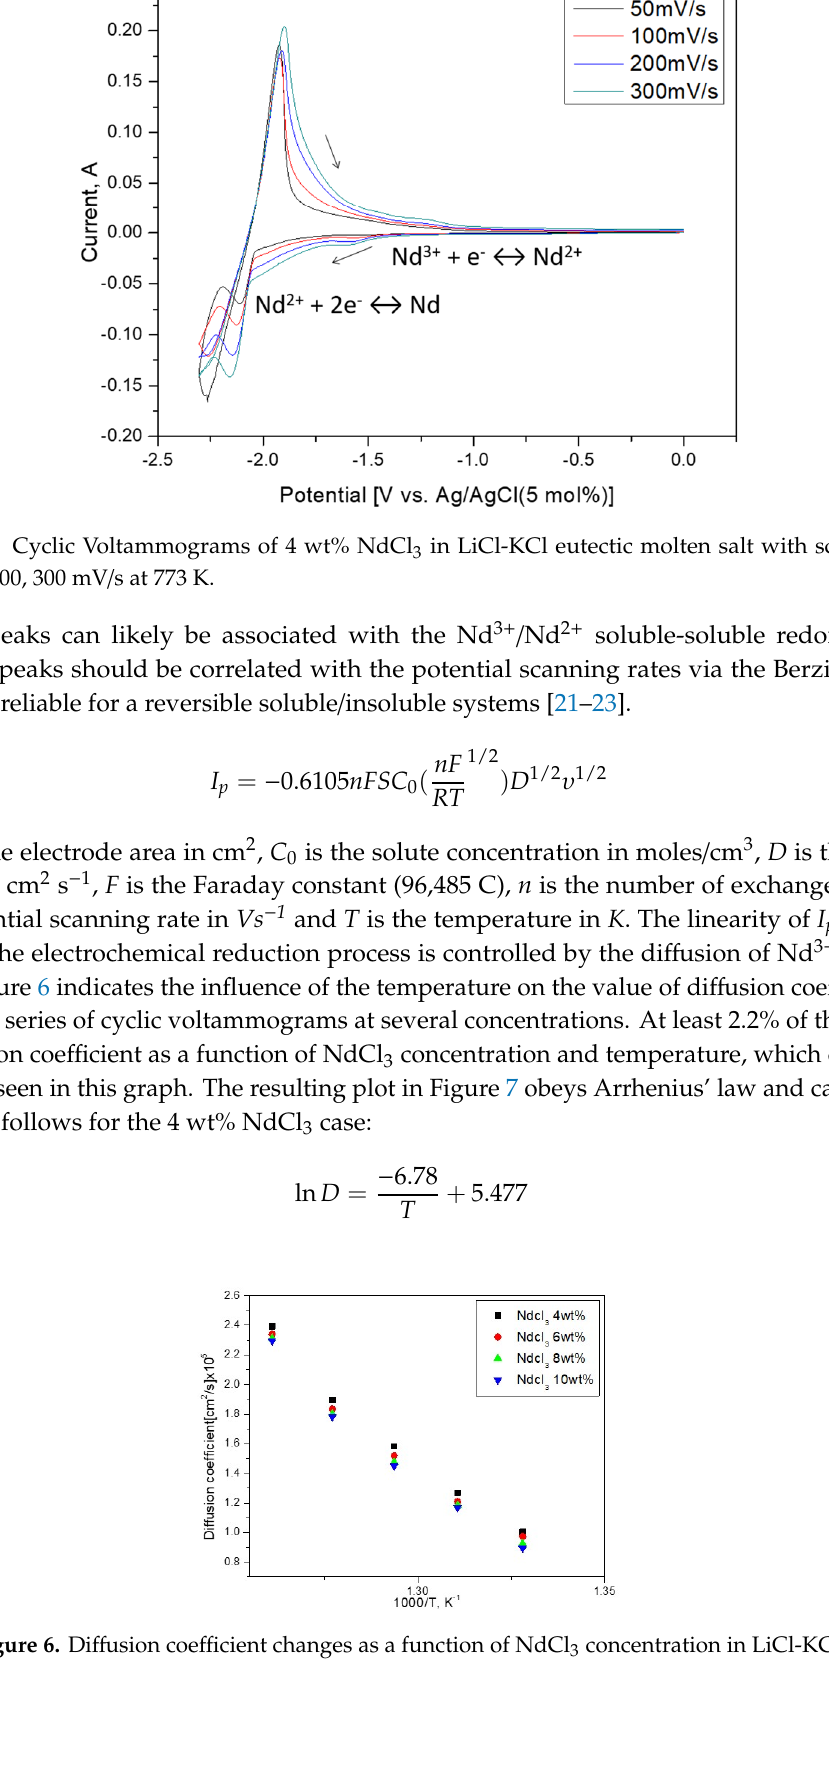
Figure 6. Di ff usion coe ffi cient changes as a function of NdCl 3 concentration in